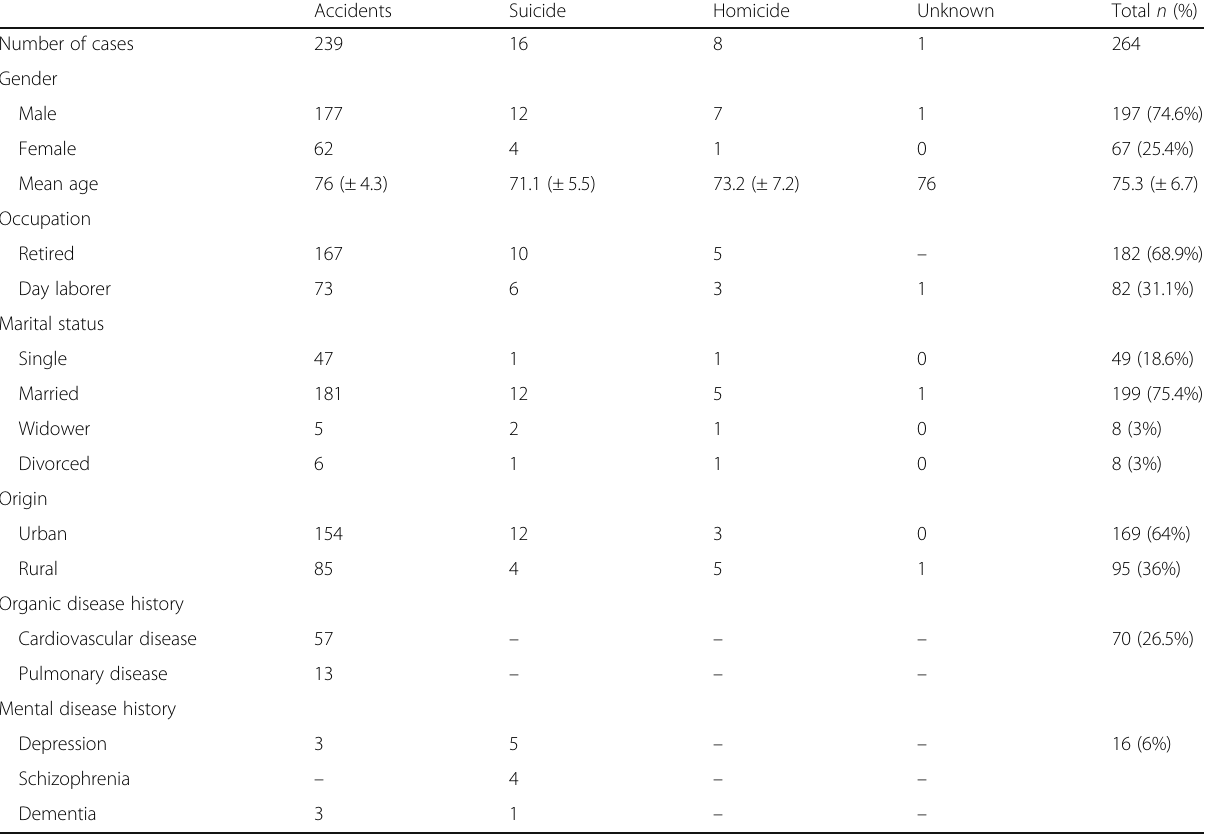
Table 1 Distribution of unnatural deaths epidemiological data